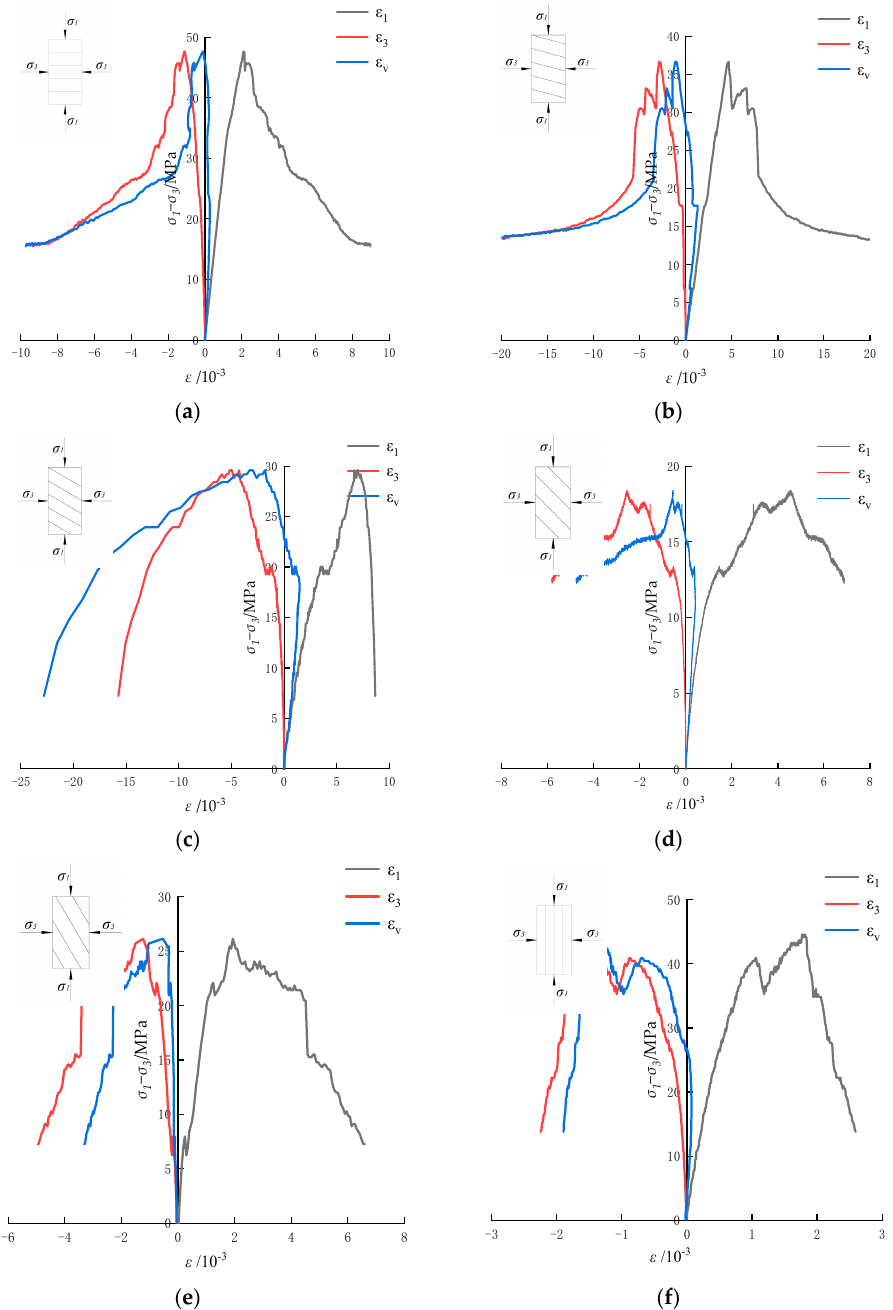
Figure 10. Deviatoric stress–strain curves of coal samples with different bedding angles under confining pressure of 9 MPa. ( a ) 0°. ( b ) 30°. ( c ) 45°. ( d ) 60°. ( e ) 75°. ( f ) 90°. The failure comparison of coal samples with different bedding planes is shown in Figure 11. It can be seen that different bedding planes lead to different failure characteris- tics of coal samples. Under confining pressure, the coal mainly suffers shear failure, and the shear failure surface mostly spreads around the weak structural surface. Coal samples with a bedding angle of 0° have local shear slip failure, and cross-penetrating cracks are formed locally on the failure surface and the bedding structure surface near the end. The failure modes of 30° and 45° coal samples are mainly based on the bedding plane as the main failure crack, and shear slip failure occurs. The coal samples containing 60° or 75° bedding planes have combined failures. The main failure is the shear failure along the bedding plane, but it also includes tensile cracks extending from the end of the sample